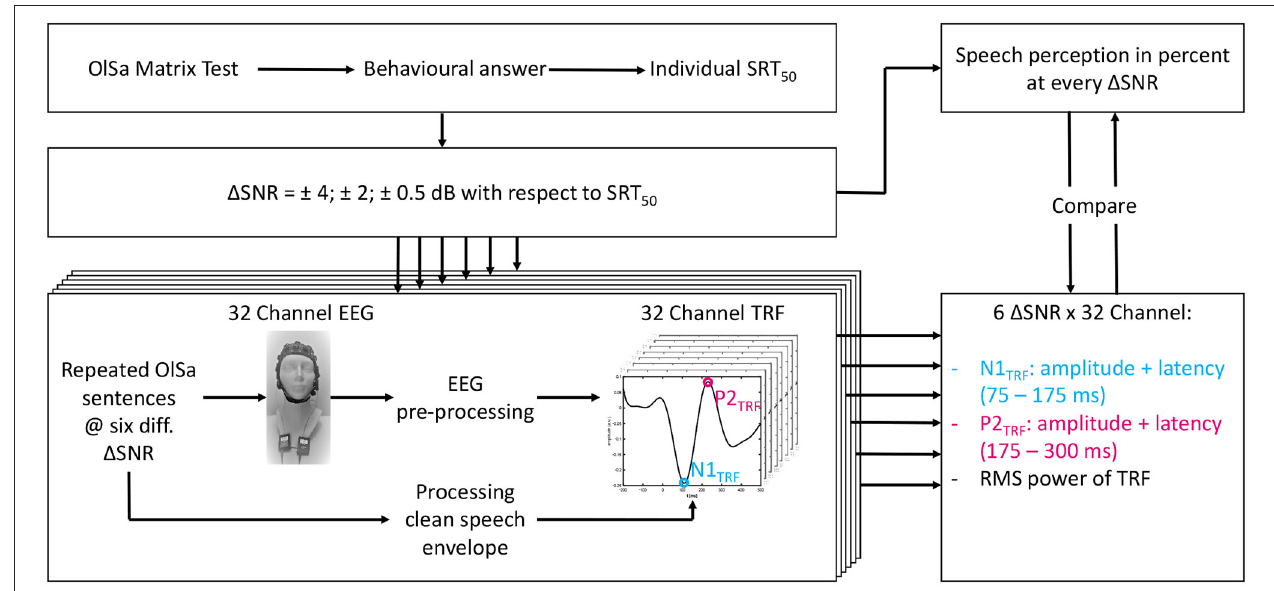
FIGURE 1 | Scheme of the test procedure for each subject. First the individual SRT 50 was obtained (upper left). The subsequent tests were all performed under six different 1 SNR conditions (defined below). TRF estimation is shown in the lower left and feature extraction in the lower right corner. Finally, features with highest correlation with speech intelligibility in per cent per 1 SNR condition were compared. All behavioral measurements took place on the first and all objective measurements on the second